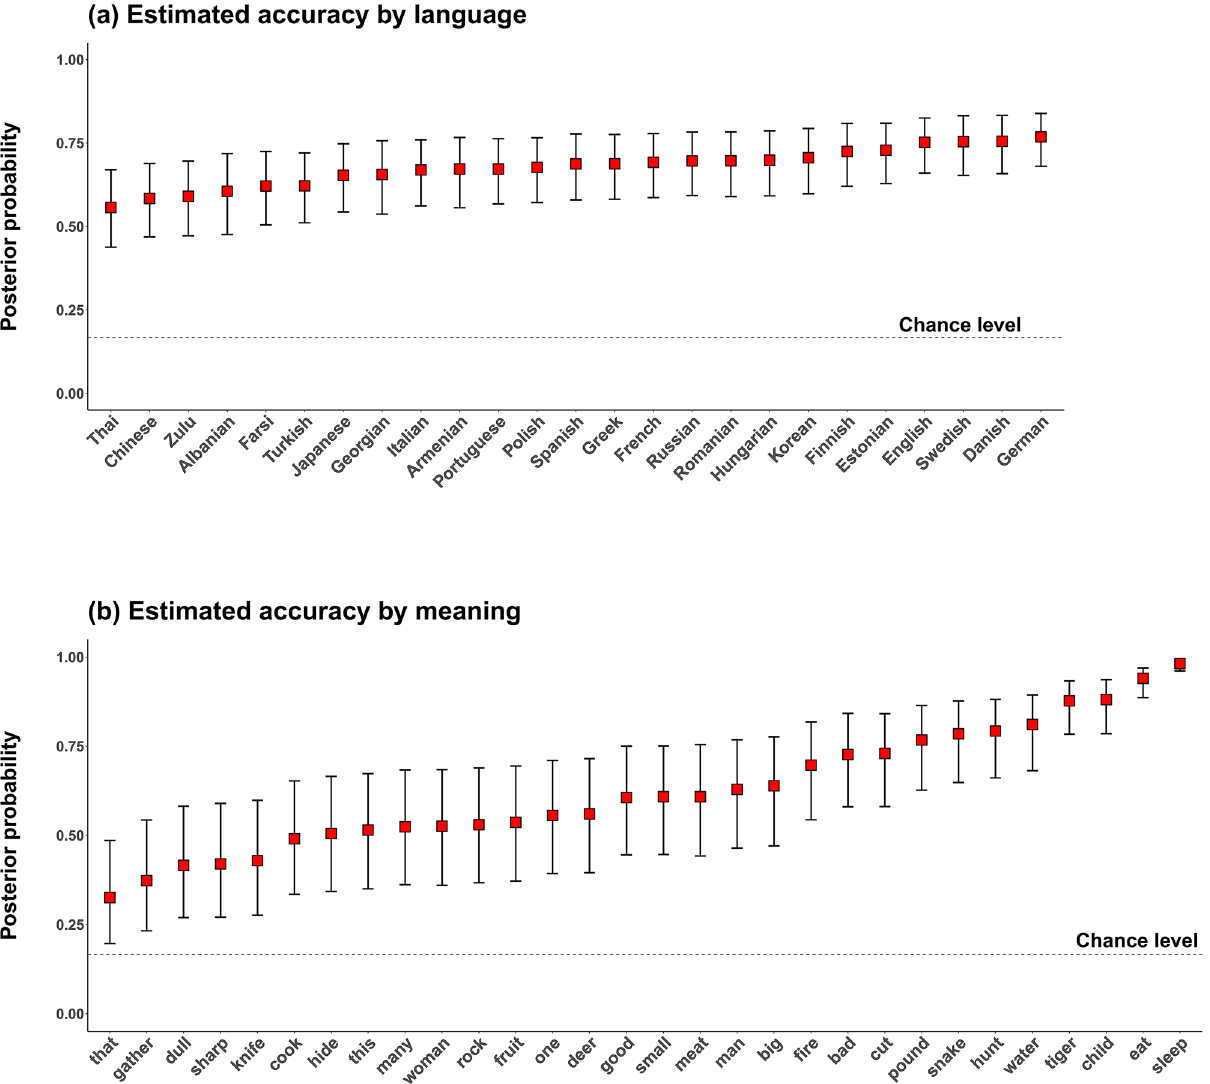
Figure 2. Posterior probability of a correct guess in the online experiment ( a ) per language and ( b ) concept; the red squares indicate the posterior means and error bars the 95% Bayesian credible intervals. The values displayed in this figure correspond to the model that takes into account random effect variation by meaning, vocalization, language, listener, and creator of vocalization.